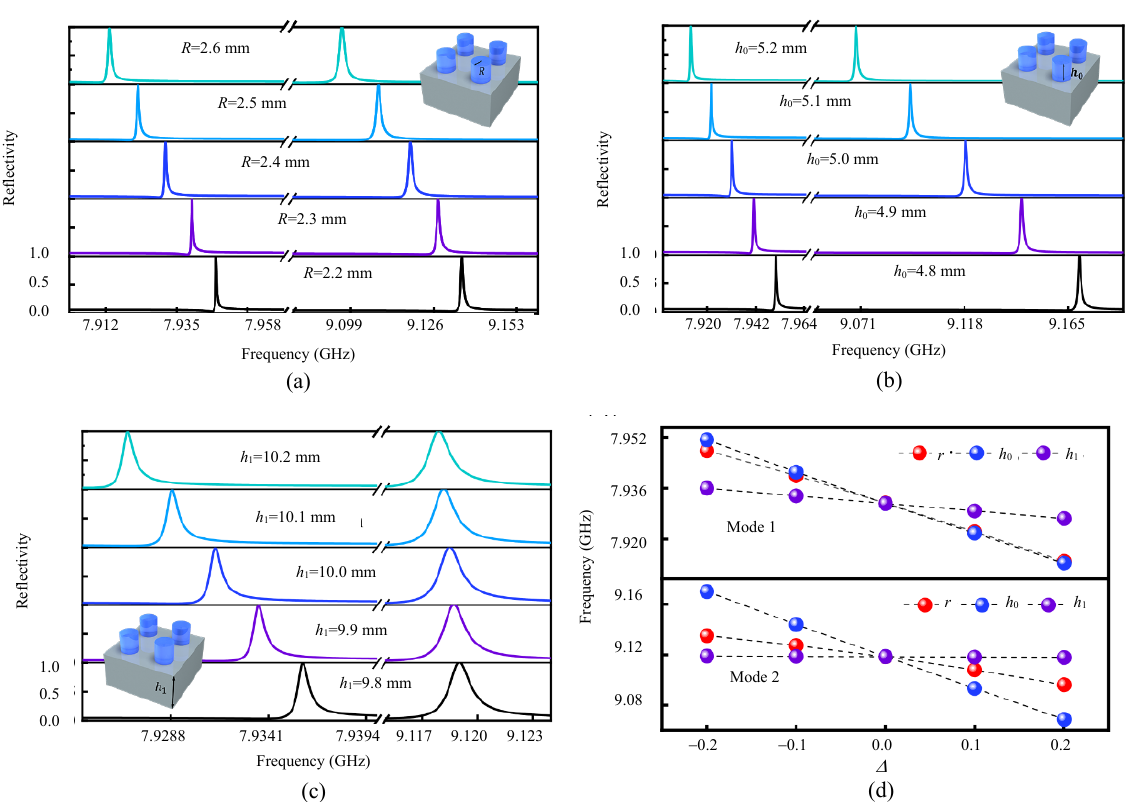
Fig. 6 Reflectance spectra of metasurface with different geometric parameters: (a)–(c) reflectance spectra of metasurface when R , h 0 , and h 1 change; (d) resonant frequencies of the two modes varying with geometric